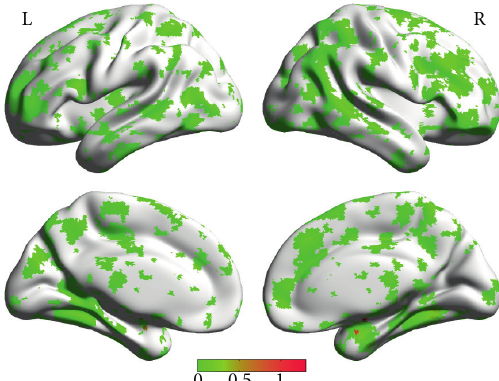
Figure 4: Effect sizes (Cohen’s f 2 ) of between-group ReHo dif- ferences (LPD vs. RPD). Cohen’s f 2 was thresholded at higher than 0.02. L indicates the left side, and R indicates the right